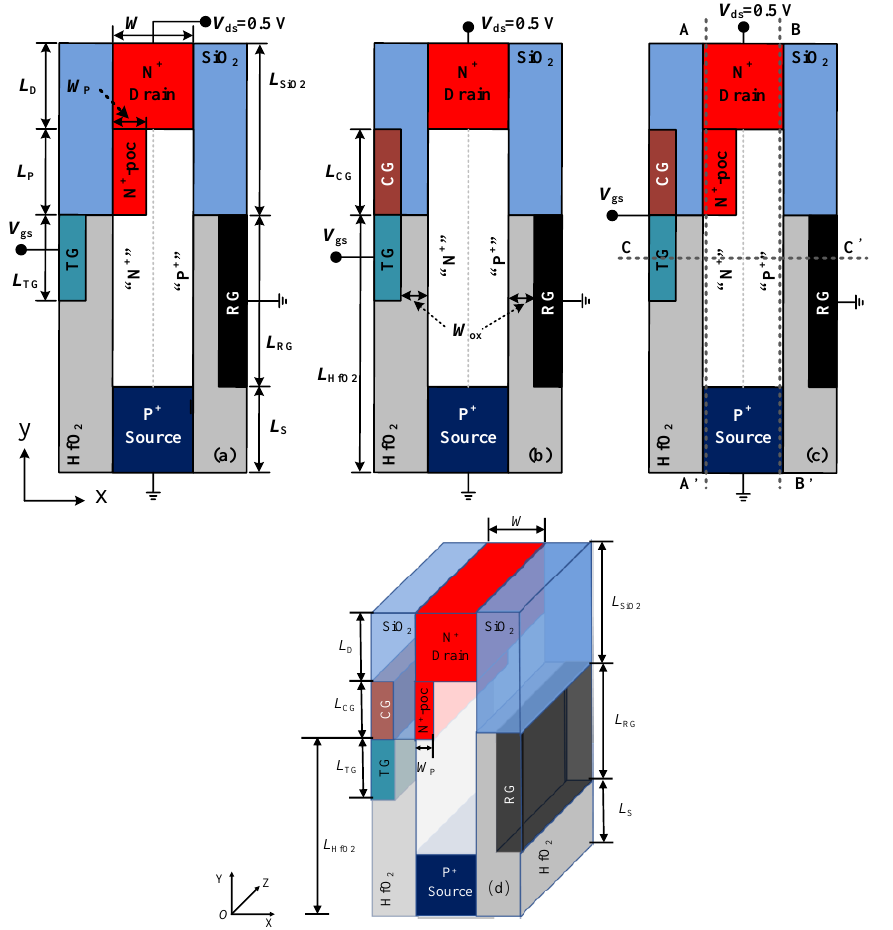
Figure 1. Cross sectional views of ( a ) NP-EHBTFET; ( b ) DG-EHBTFET; and ( c ) DGNP-EHBTFET. ( d ) A 3D schematic of DGNP-EHBTFET. Cutlines A–A’ and B–B’ are located at 0.5 nm on the right side of the left-gate dielectric and the left side of the right-gate dielectric, respectively, and cutline C –C’ is located in the middle of the tunneling -gate. Table 1. Device structure parameters used in simulations.